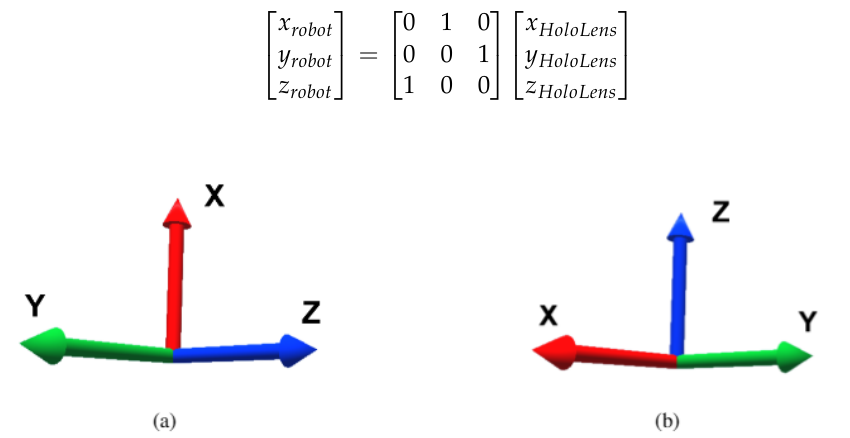
Figure 5. Coordinate system comparison: ( a ) AR application coordinate system. ( b ) Robots’ coordi- nate